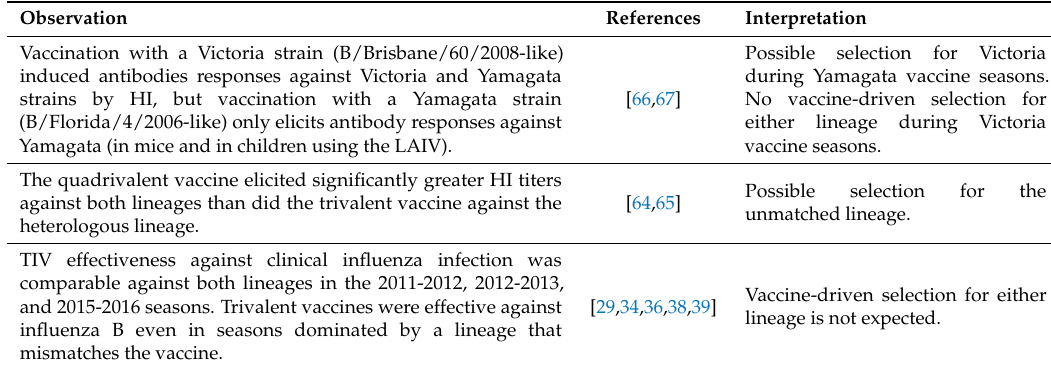
Table A4. Evidence for potential vaccine-driven selection among influenza B